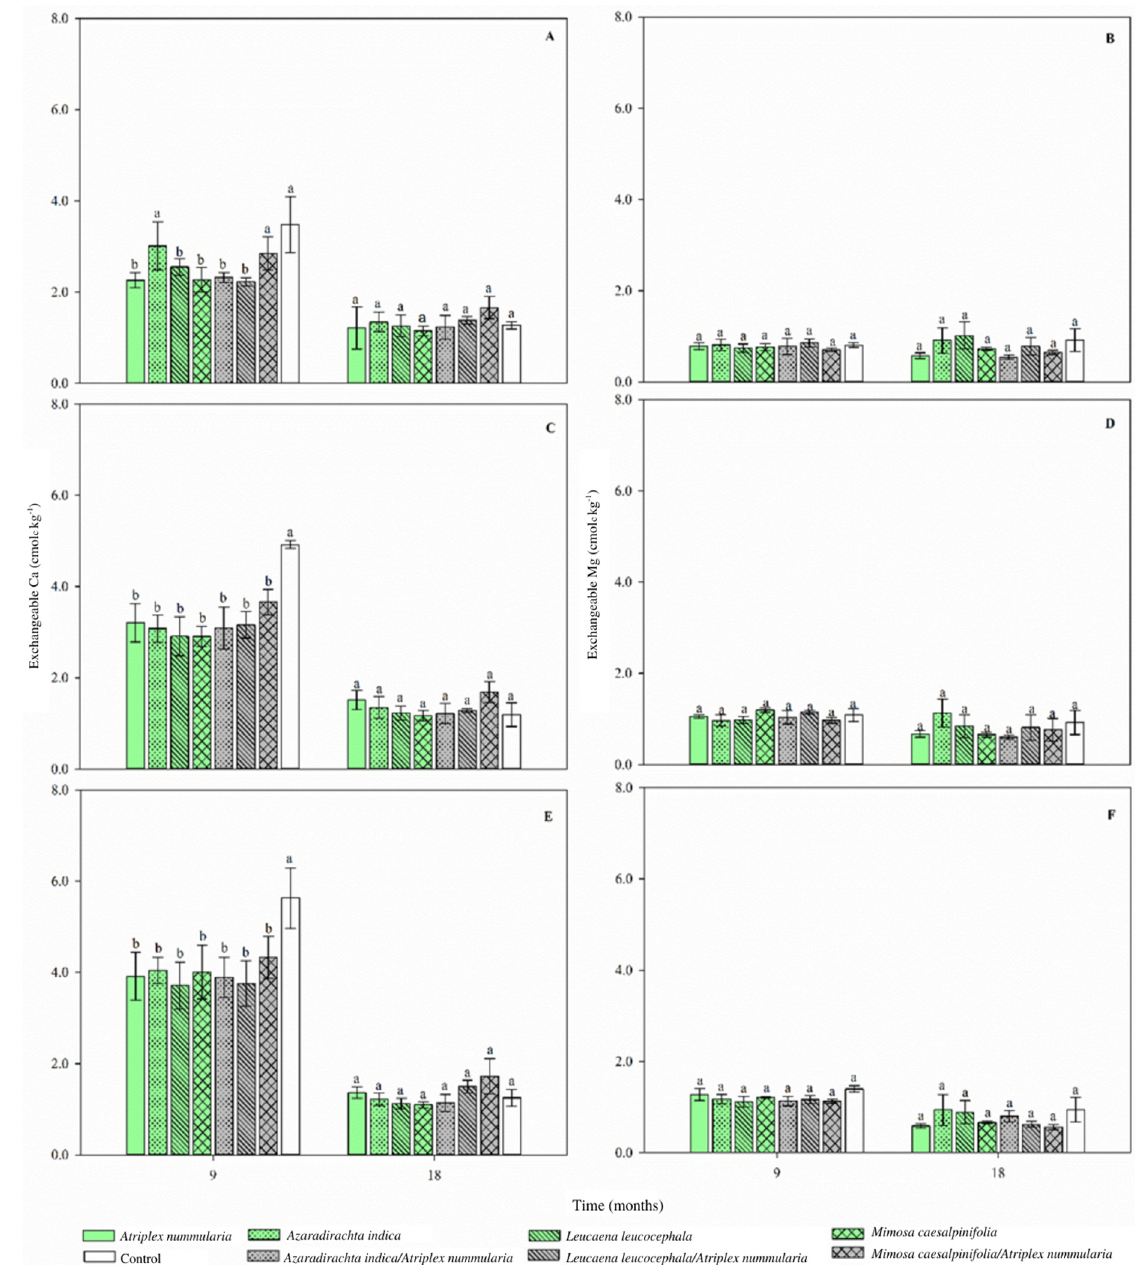
Figure 3. Exchangeable Ca 2+ [( A ) 0–10 cm; ( C ) 10–30 cm; ( E ) 30–60 cm] and Mg 2+ [( B ) 0–10 cm; ( D ) 10–30 cm; ( F ) 30–60 cm] at 9 and 18 months as result of the applied treatments. (Averages of four replications). Averages followed by the same letter have no difference in the same layer and time of sampling by the Skott-Knott test ( p ≤ 0.05).